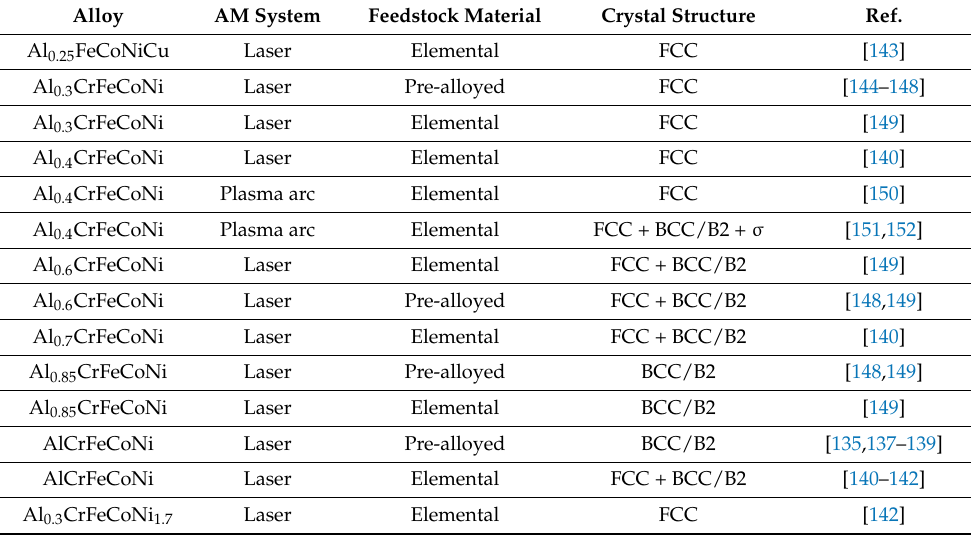
Table 5. HEAs produced by BPD process as part of direct metal deposition (DMD)